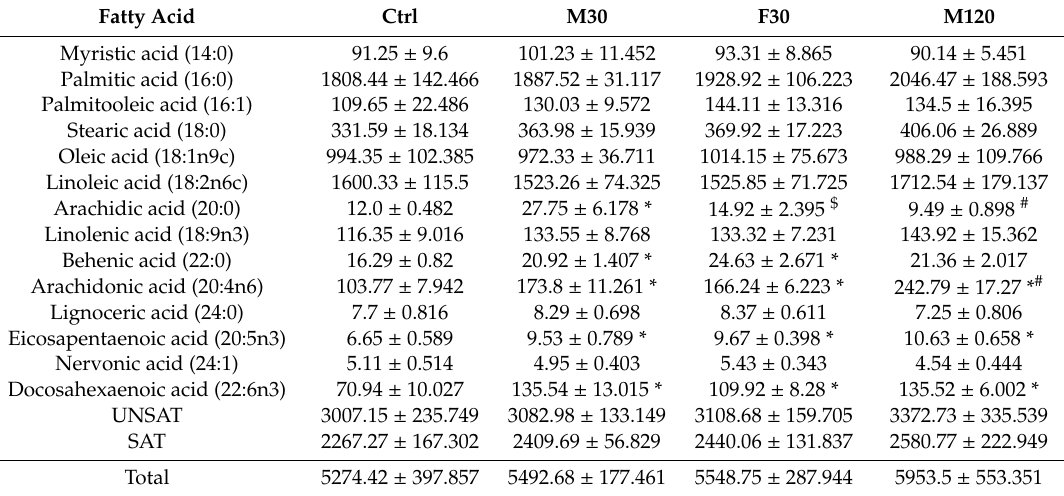
Table A3. The left ventricle TG—fatty acid composition (nmol / g of wet tissue).